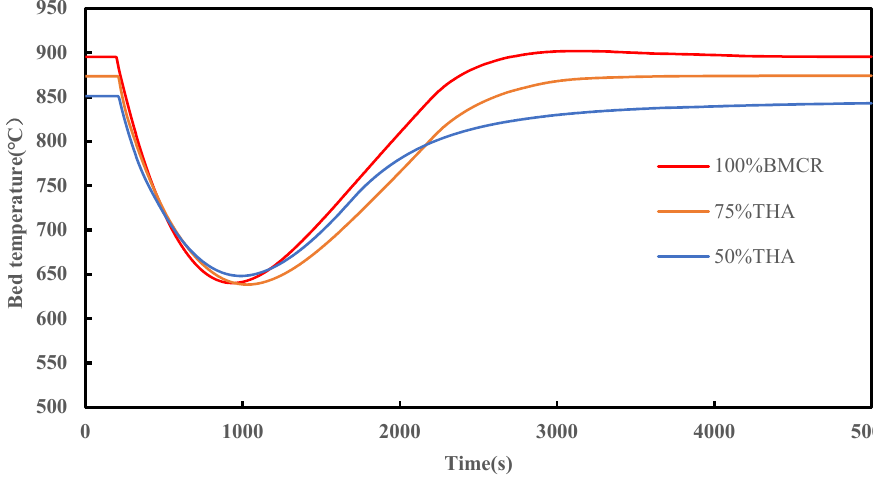
Figure 13. Response of bed temperature during BT at different conditions.